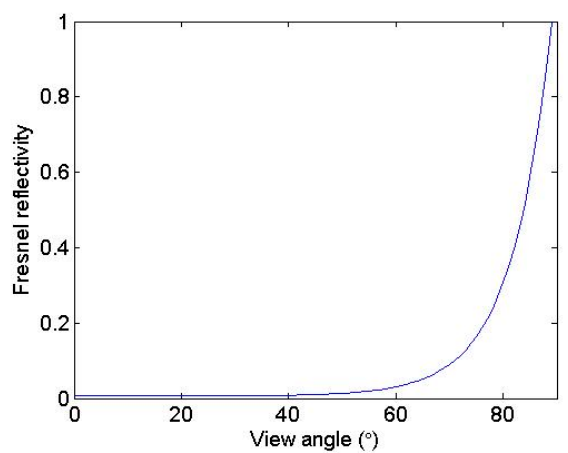
Figure 5. The Fresnel reflectivity of sea water at a wavelength of 11 µm.